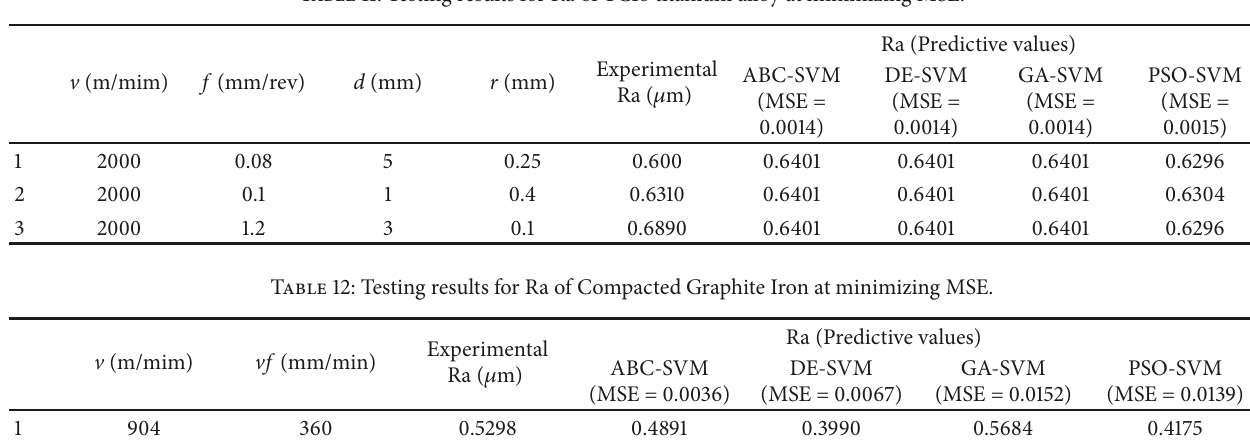
Table 11: Testing results for Ra of TC18 titanium alloy at minimizing MSE.